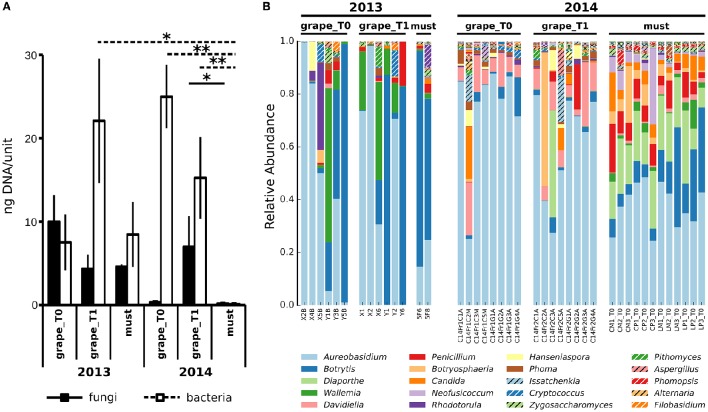
Microbial populations in Corvina grapes and fresh musts. (A) Total amount of fungal and bacterial DNAs, estimated by mean of qRT-PCR based on the ITS1 and 16S ribosomal sequences for fungi and bacteria, respectively. Values indicate the amount of fungal or bacterial DNA quantified in 4 grapes or 2 ml of musts per sample. *Wilcoxon-Mann-Whitney FDR < 0.05, **Wilcoxon-Mann-Whitney FDR < 0.01. (B) Composition profiles of Vitis vinifera L. cv. Corvina grapes and musts mycobiota. Relative abundance of operational taxonomic units (OTUs) from fungal species in Vitis vinifera L. cv. Corvina grape and must samples. Colors correspond to genera, the 20 most abundant genera are listed in the figure legend.